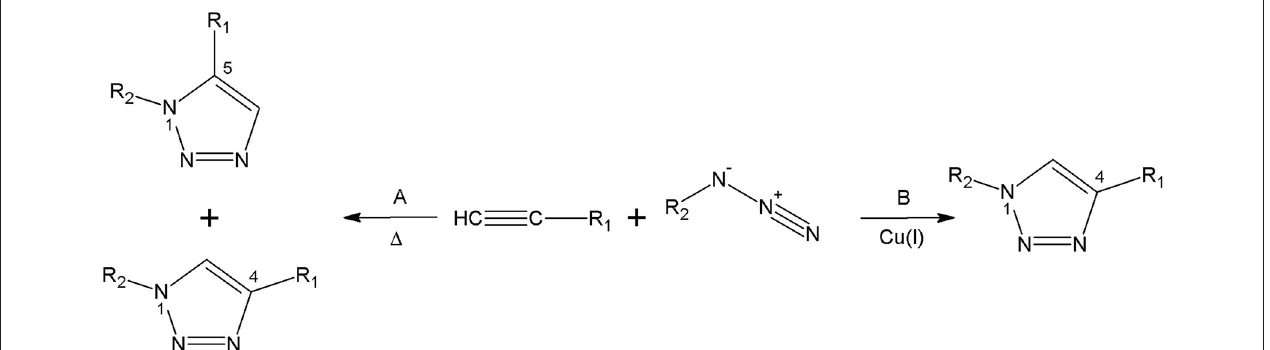
FIGURE 3 | The Huisgen cycloaddition. (A) Under thermal conditions and (B) catalysed by Cu(I)